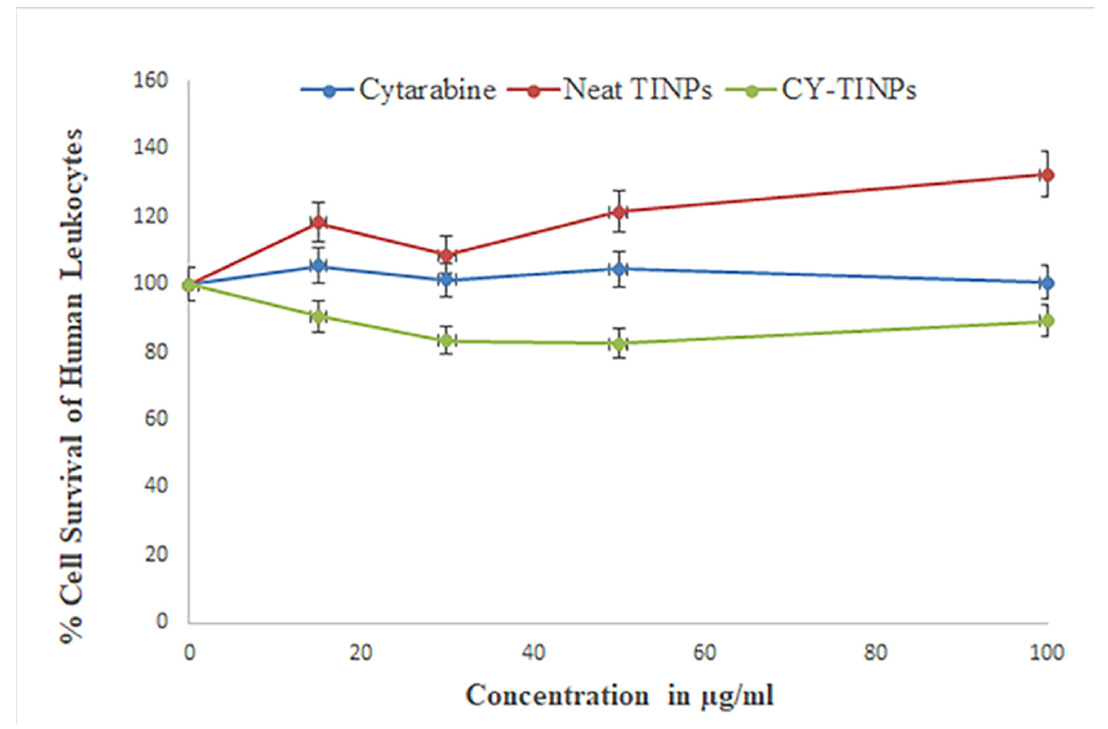
Figure 9. In vitro cell cytotoxicity study graph of cytarabine, neat TINPs, and cytarabine-loaded TINPs (CY-TINPs).